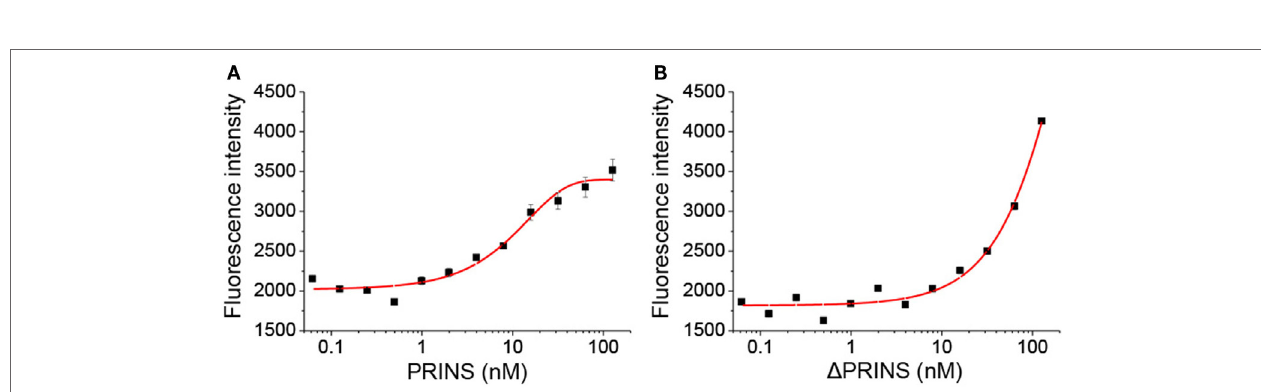
FigUre 5 | PRINS specifically binds to interleukin-6 (IL-6) mRNA. The binding affinity of PRINS (a) and Δ PRINS (B) to IL-6 mRNA was determined by analyzing the initial fluorescence enhancement caused by specific binding. The concentration of labeled IL-6 mRNA was constant (10 nM), while the concentration of PRINS and Δ PRINS varied from 62 pM to 127 nM.